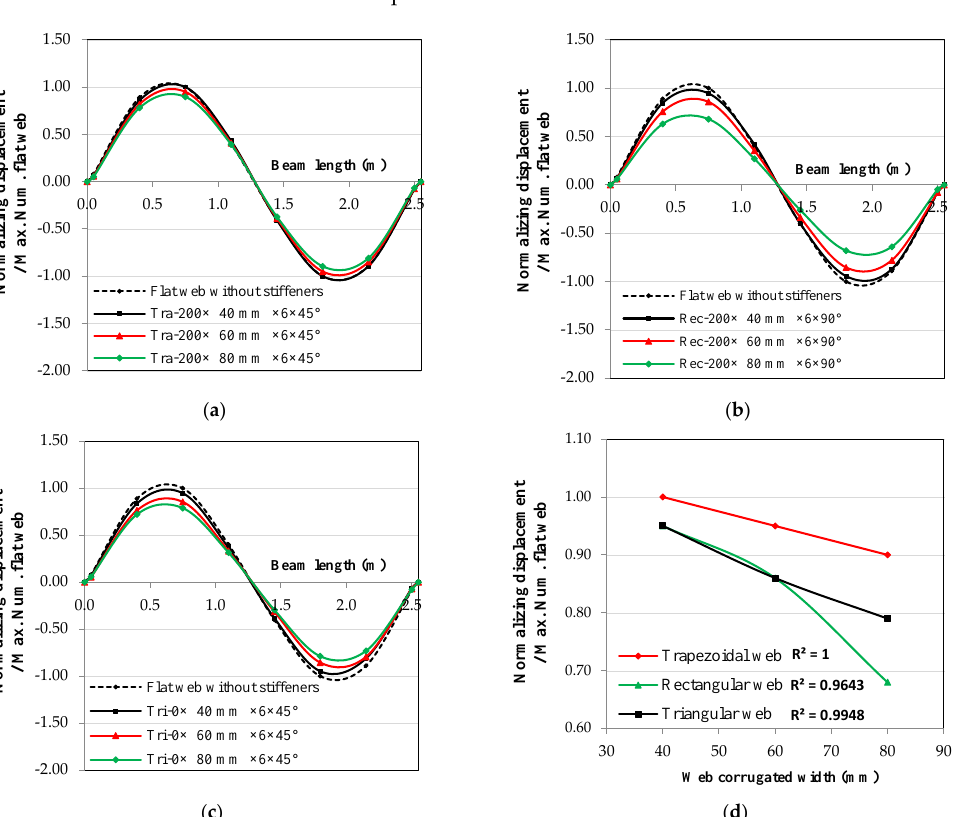
Figure 13. Corrugated width effect on the relationship between normalized displacement and beam length for the 2nd mode shape: ( a ) trapezoidal web, ( b ) rectangular web, ( c ) triangular web, and ( d ) width effect at the 2nd mode shape.